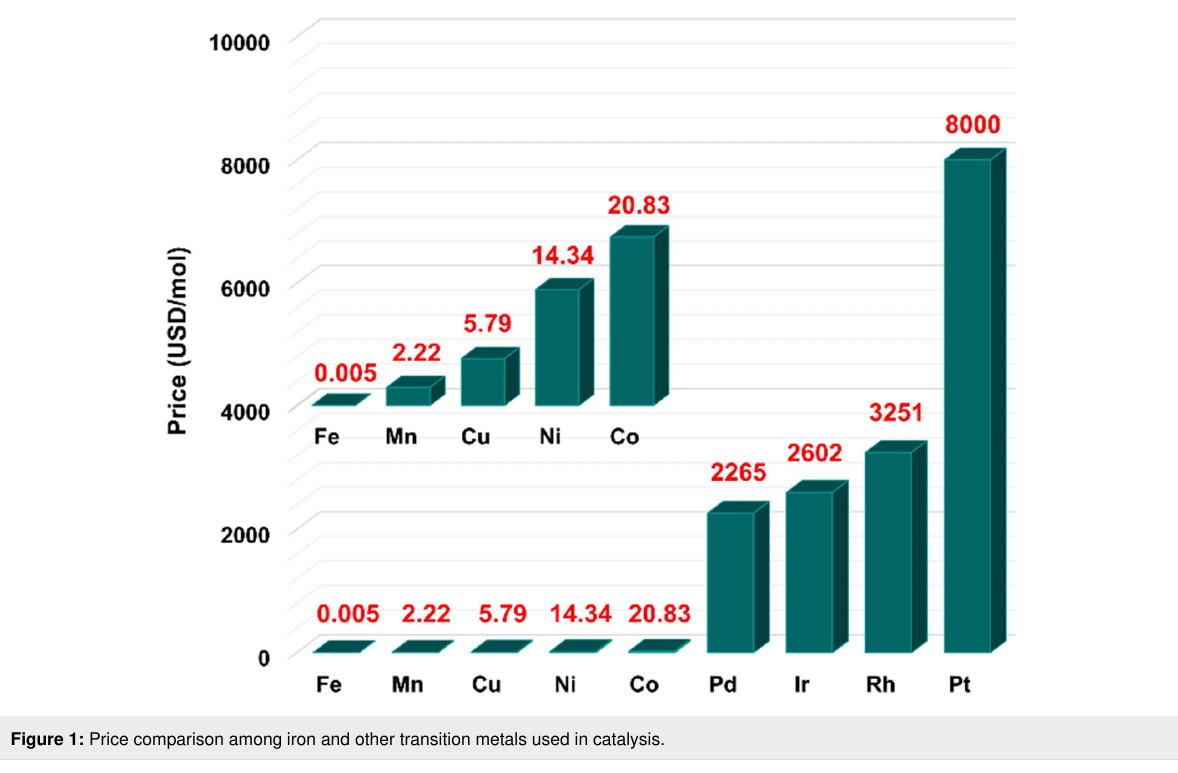
Figure 1: Price comparison among iron and other transition metals used in catalysis.